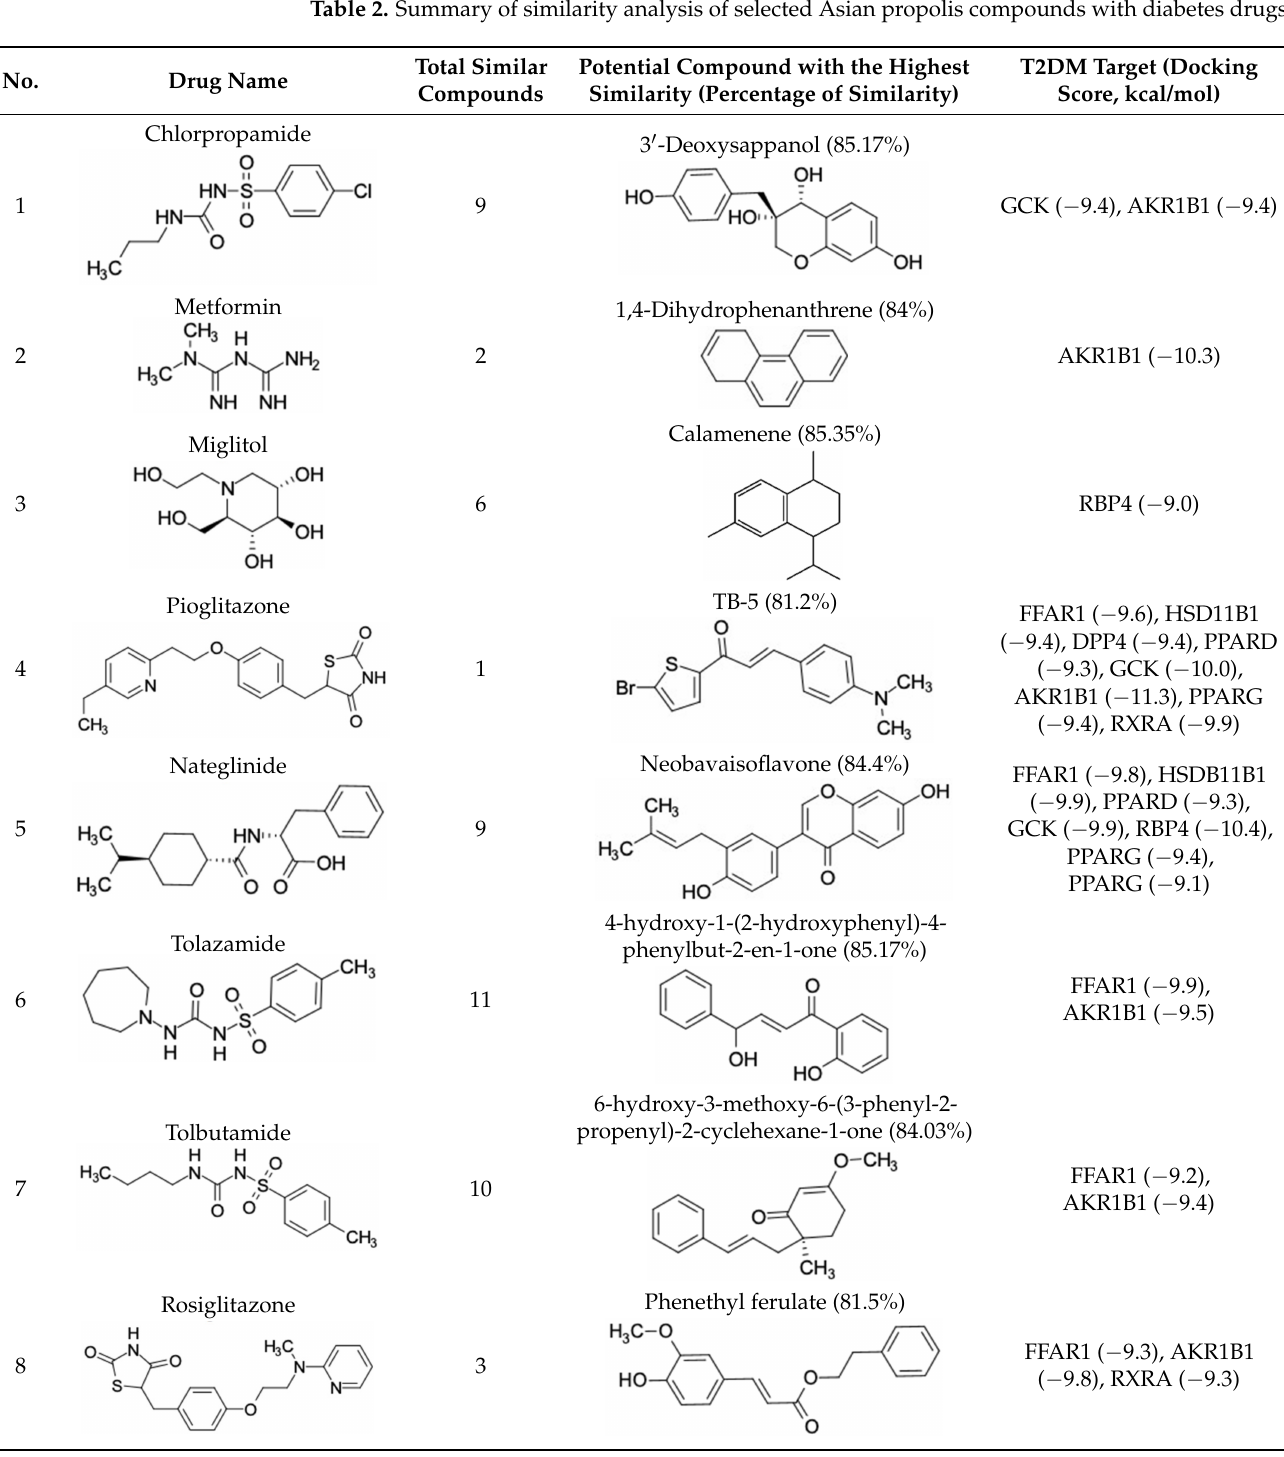
Table 2. Summary of similarity analysis of selected Asian propolis compounds with diabetes